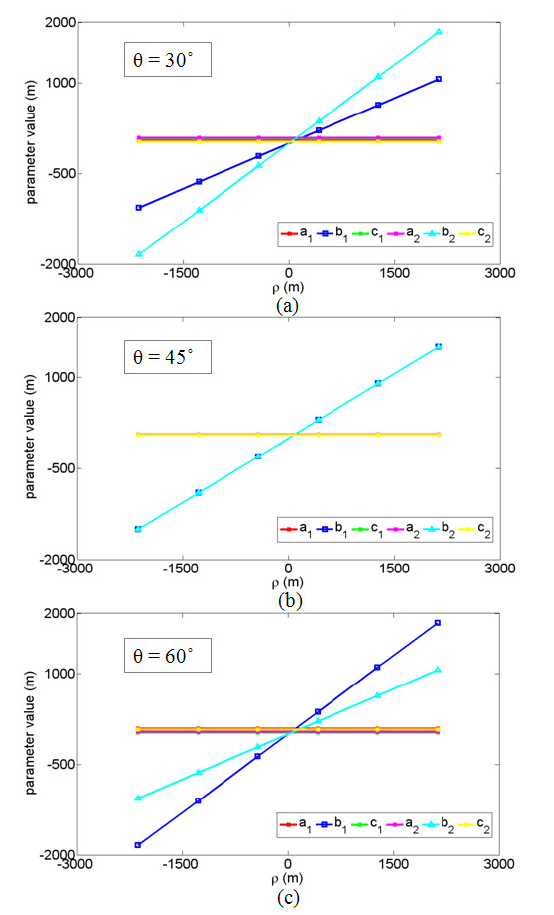
Figure 6. Values of a 1 , b 1 , c 1 ; a 2 , b 2 , c 2 vs ρ for constant θ